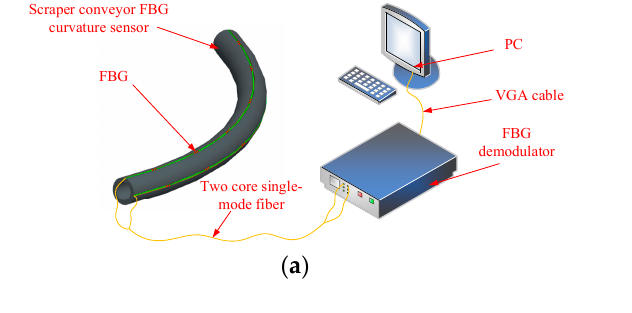
demodulatorPC FBG